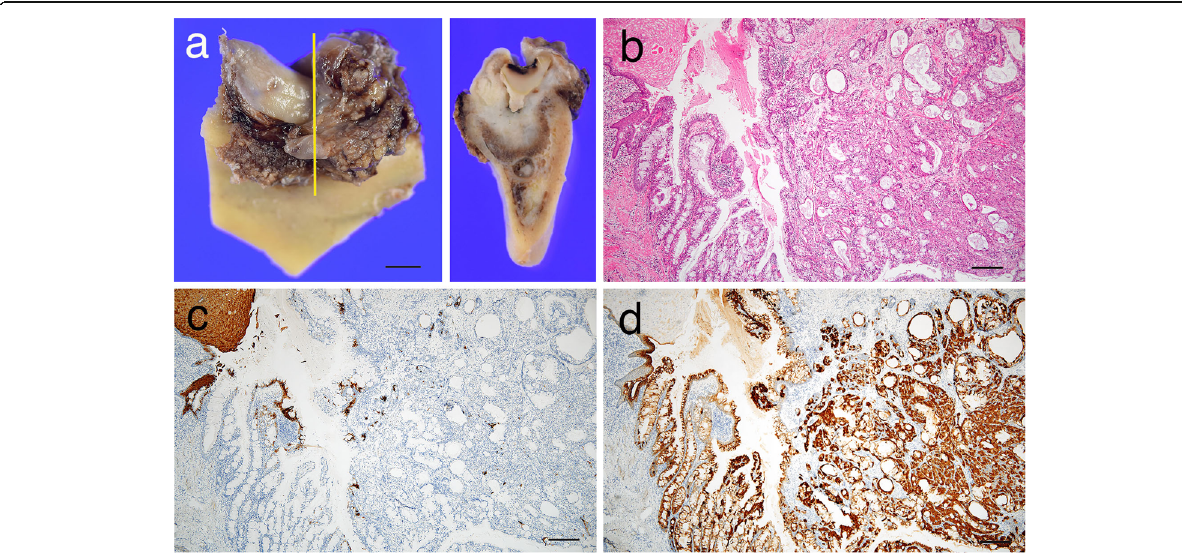
Fig. 4 The surgical specimen after the biopsy showing central MEC. a The operative surgical specimen of the mandible. The specimen was cut before decalcification in a part (yellow line). The tumor expanded to the submucosal area from the mandibular bone in the cut surface ( b ) Tumor with many cystic spaces expanded into the submucosal area of the gingiva. c, d Immunoreactivity for CK18 was positive in central MEC, but negative for CK13. Scale bars, 10 mm ( a ), 200 μ m ( b – d